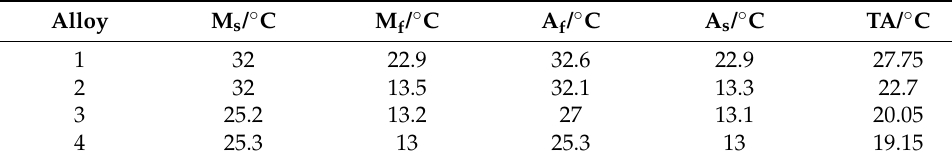
Table 3. Transformation temperatures as per DSC